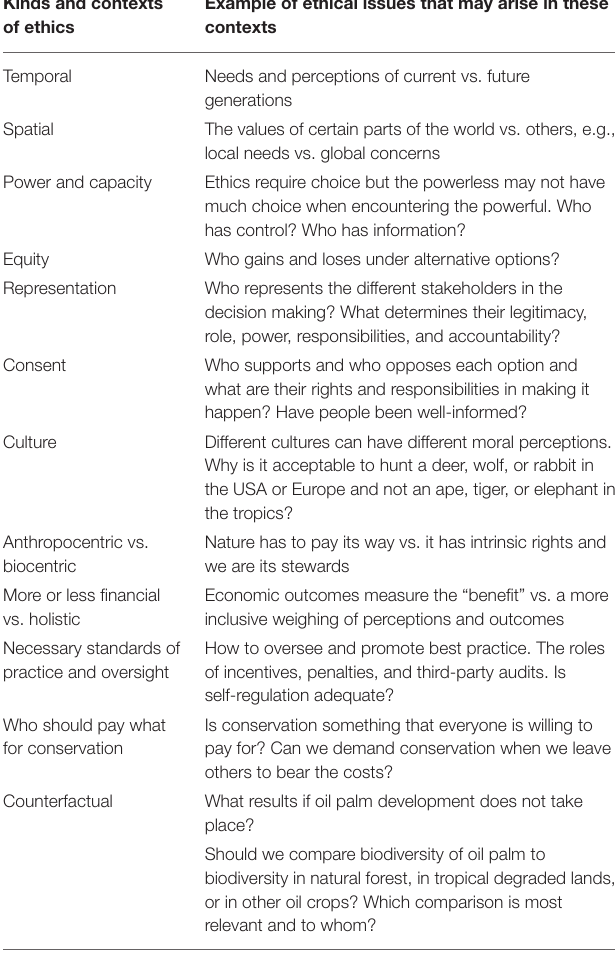
TABLE 1 | Outline of the different kinds of ethical challenges and perspectives at play in any one situation, which could also lead to different ethical outcomes or end-points.